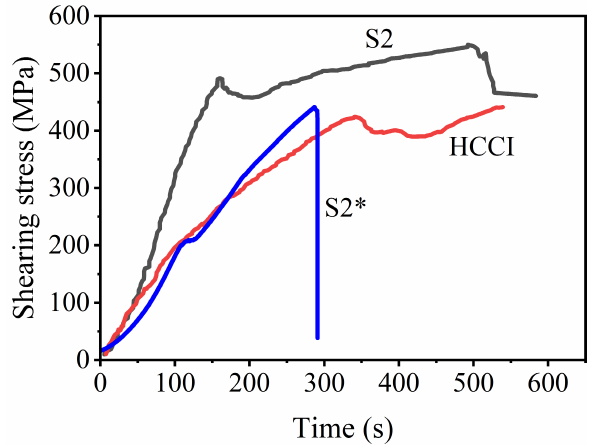
Figure 12. Typical shearing stress vs. test time curves of bimetallic and HCCI samples.